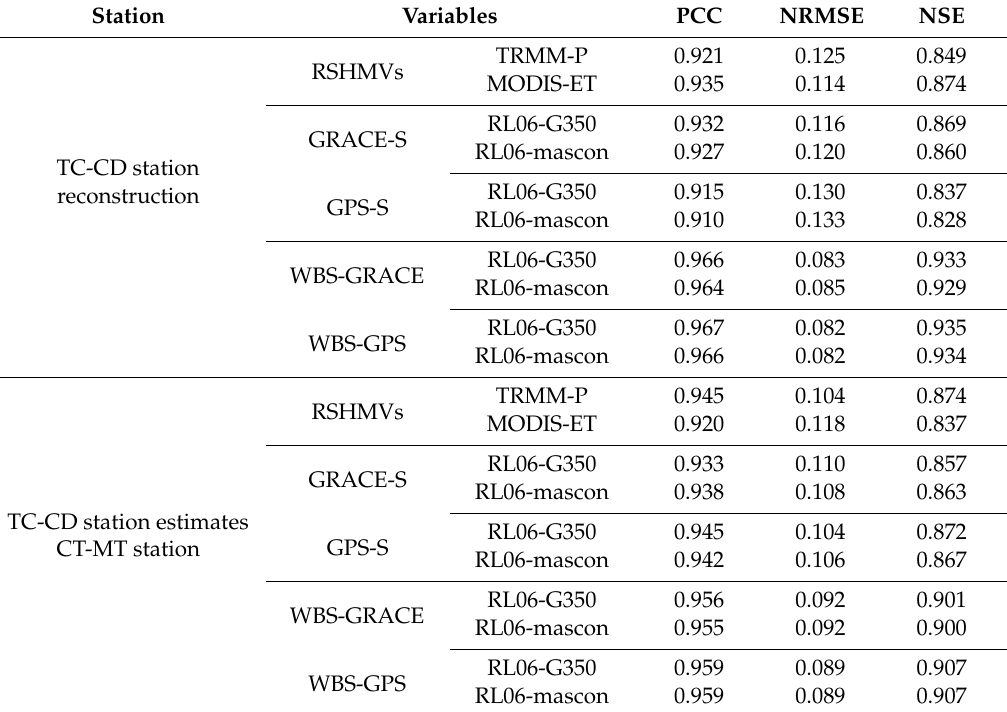
Figure 6. Reconstructed runo ff based on the water balance standardization (WBS) approach for ( a , b ) GRACE water storage (GRACE-S) from CSR RL06 with a 350-km Gaussian filtering (G350) and its mascon solution, and ( c , d ) GPS-inferred water storage (GPS-S) from CSR RL06 with a 350-km Gaussian filtering (G350) and its mascon solution at Can Tho and My Thuan (CT-MT) station. Table 3. Internal assessment for reconstructed runo ff at Tan Chau–Chau Doc (TC-CD), and external assessment for estimated runo ff at Can Tho–My Thuan (CT-MT) using the determined parameters during runo ff reconstruction at Tan Chau–Chau Doc